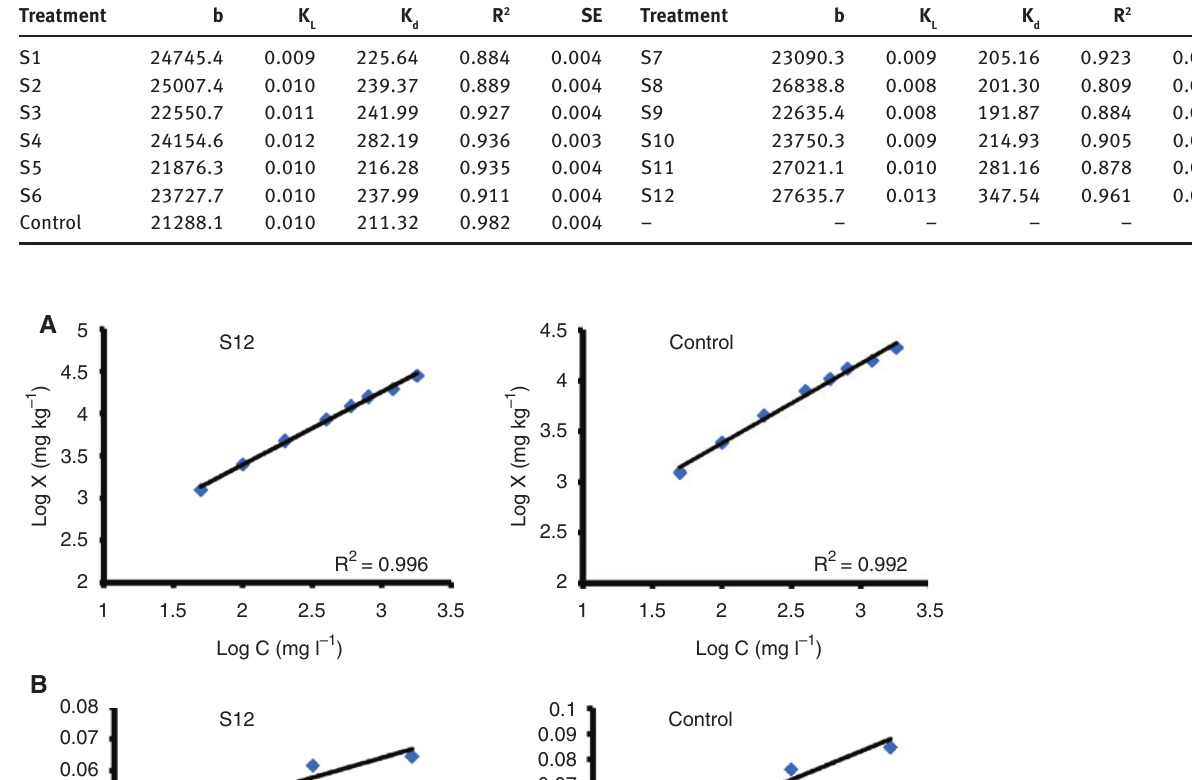
Table 7: Coefficients of the Langmuire sorption isotherm, R 2 , and SE for the Cd sorptions of different treatments.